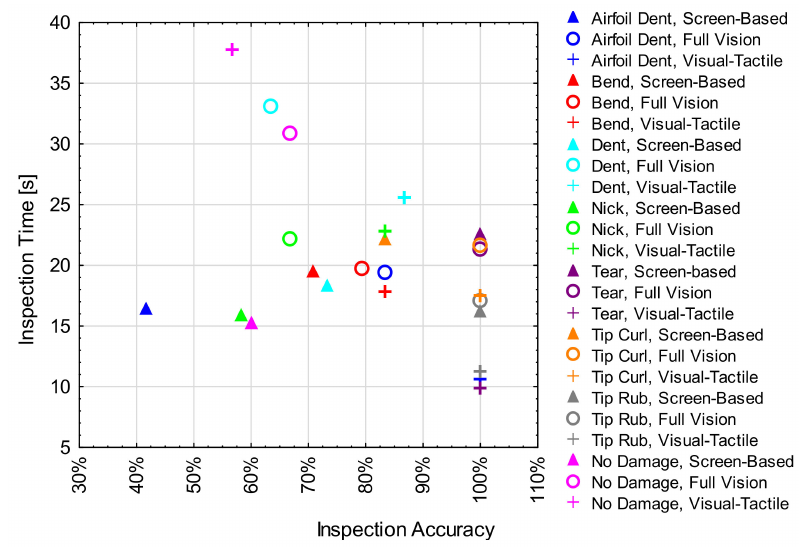
Figure 13. Scatter plot of inspection time and inspection accuracy for each defect type and inspection method. ‘No damage’ refers to non-defective blades and acceptable